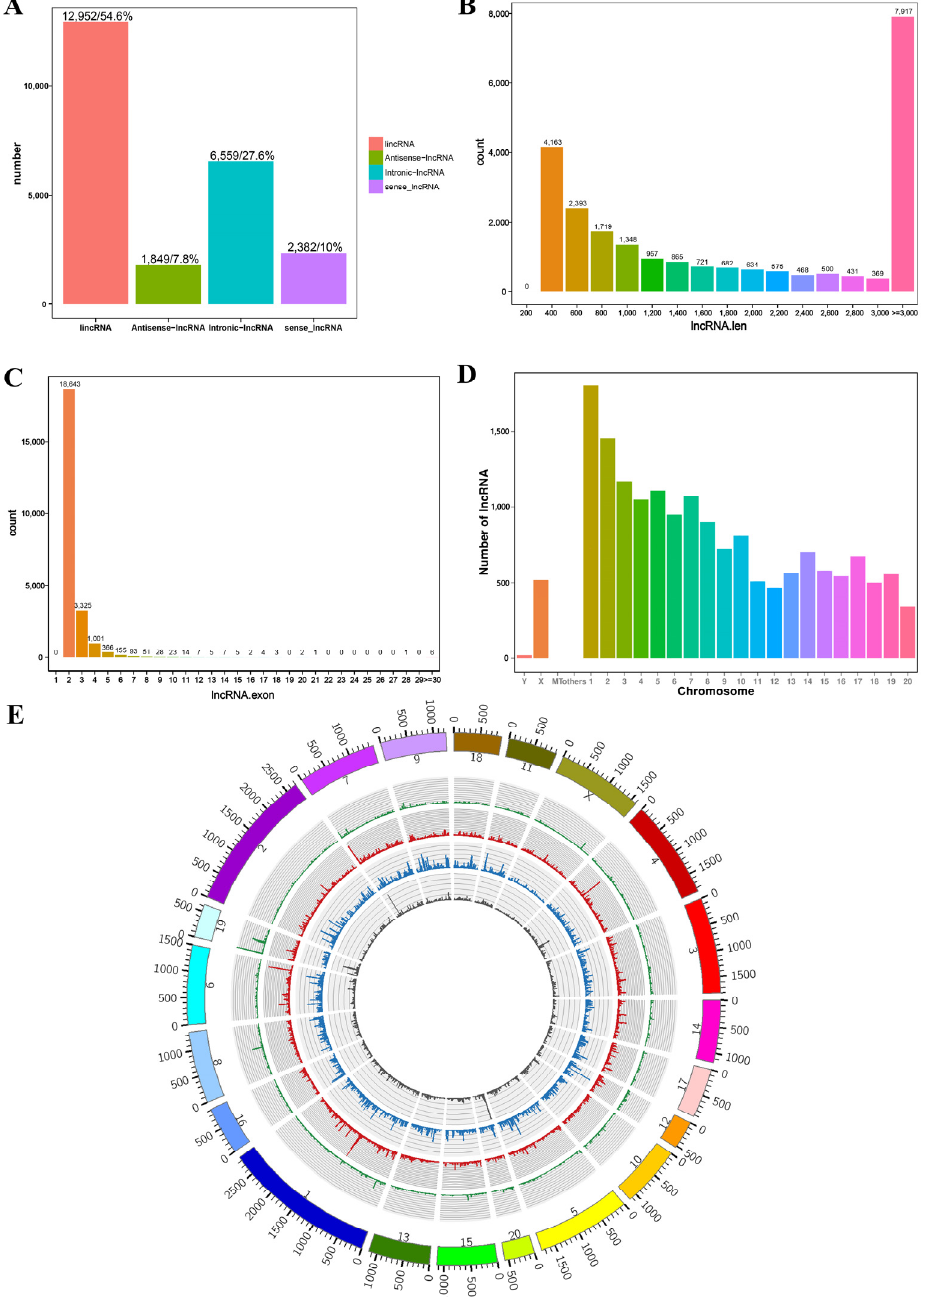
Figure 1. Results of lncRNA sequencing in the adenohypophysis of rats after GnRH treatment. ( A ) LncRNA types and numbers. ( B ) Statistical analysis of LncRNA lengths. ( C ) Statistical analysis of LncRNA exon number. ( D ) Locational distribution of lncRNAs on rat chromosomes. ( E ) Circos plot containing lncRNA data.